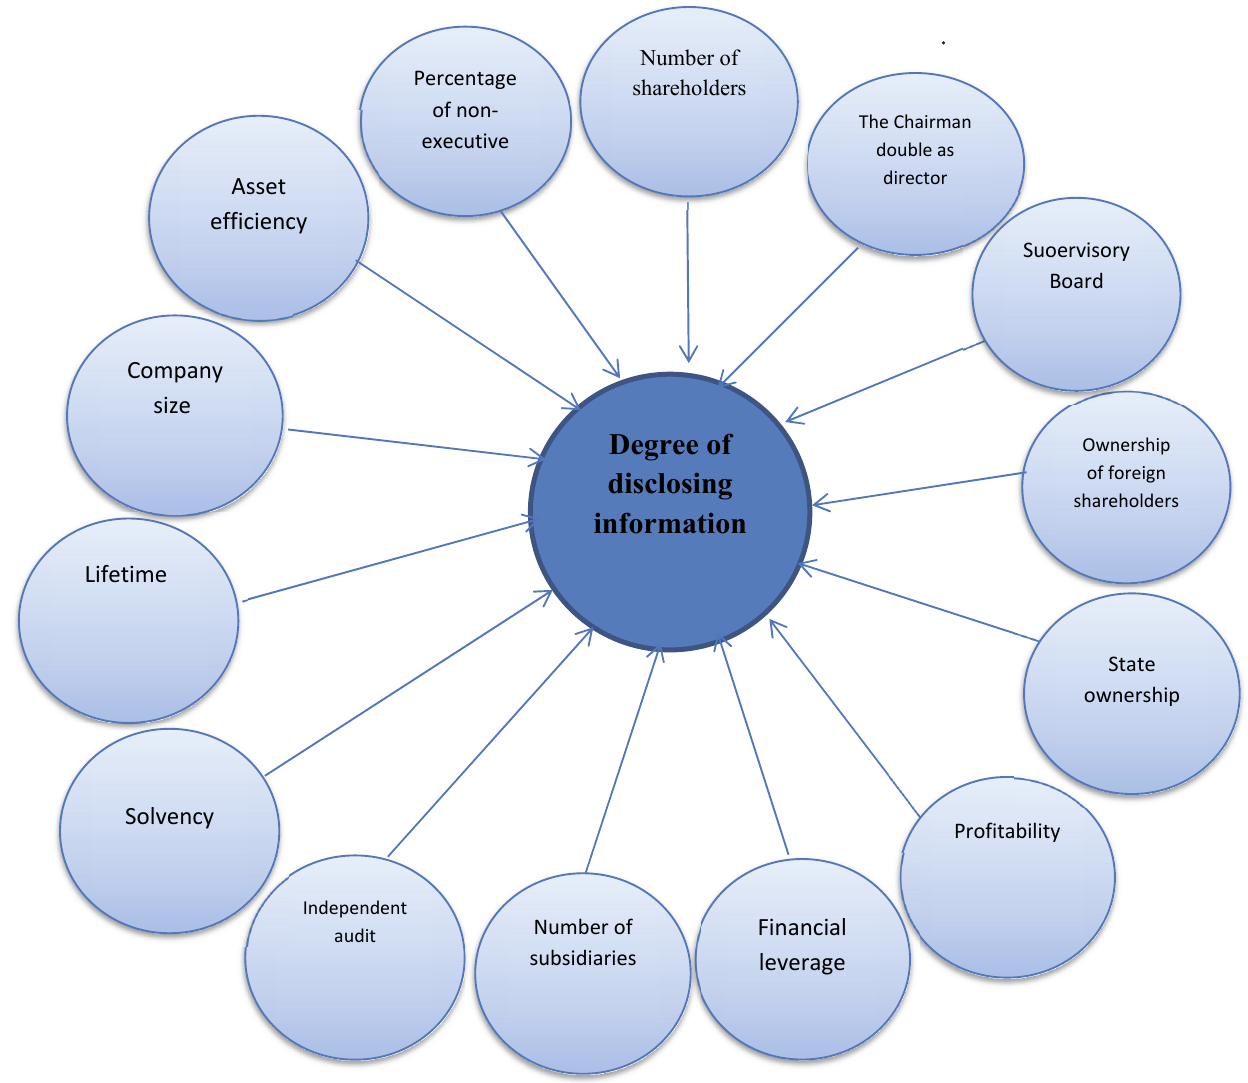
Fig. 1. Factors affecting the degree of the accounting information disclosure of public listed companies of the food industry